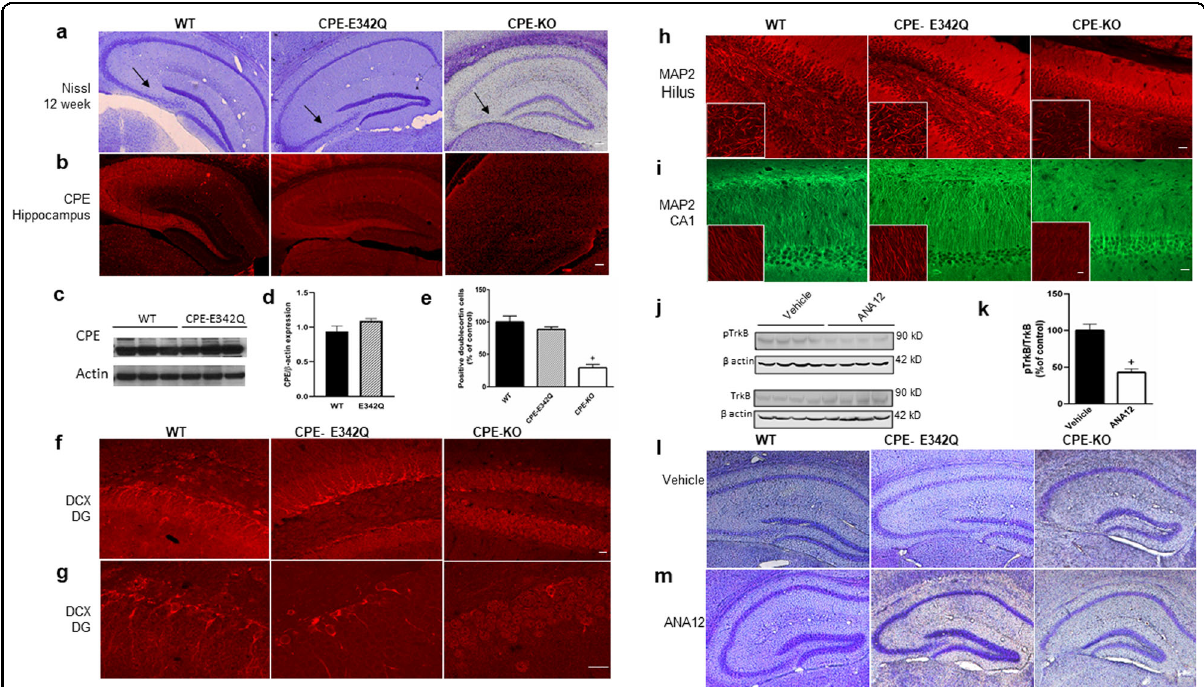
Fig. 3 CPE-E342Q mice show no hippocampal neurodegeneration after weaning stress, unlike CPE-KO mice, and this effect was not blocked by TrkB inhibitor. a Representative sections of Nissl staining of coronal anterior hippocampus of 12-week-old WT, CPE-E342Q, and CPE-KO mice. CPE-E342Q mice showed an intact hippocampus similar to WT mice, however, CPE-KO mice exhibited complete degeneration of the CA3 region (see arrow). Scale bar = 100 μ m. n = 3 mice per genotype. b Immunohistochemistry of representative sections showing intense CPE staining in hippocampal CA1 and CA3 regions in WT and CPE-E342Q mice, but absence in CPE-KO mice. Sale bar = 100 μ m. n = 3 mice per genotype. c , d Western blot and quanti fi cation of expression of CPE in the hippocampus of WT and CPE-E342Q mice. Student ’ s t test, p = 0.149. n = 3 mice per genotype. Values are mean ± SEM. e Bar graphs showing % of DCX positive cells in the dentate gyrus of CPE-E342Q mice compared to WT and CPE- KO mice. Note the decreased number of DCX positive cells in CPE-KO but not CPE-342Q mice. One-way ANOVA analysis followed by Tukey ’ s post hoc multiple comparison test, [ F (2,6) = 43.32, p = 0.0003]. + p = 0.0003 for CPE-KO mice compared with WT which was made = 100%. n = 3 per each genotype. Values are mean ± SEM. f , g Representative confocal images captured at 20X and 60X, respectively, of doublecortin (DCX) immuno fl uorescence staining showing decreased hippocampal dentate gyrus (DG) neurogenesis in CPE-KO mice, but not in WT and CPE-E342Q mice. Scale bars in F = 20 μ m and G = 20 μ m. n = 3 mice per genotype. h MAP2 immuno fl uorescence staining images captured at 20X and 60X (left bottom insert) showing decreased MAP2 intensity in the hilus of CPE-KO mice, but not in WT and CPE-E342Q mice. n = 3 per genotype. Scale bar = 20 μ m. i MAP2 immuno fl uorescence staining images captured at 20X and 60X (left bottom insert) showing decreased MAP2 intensity in the hippocampal CA1 region of CPE-KO mice, but not in WT and CPE-E342Q. n = 3 per genotype, Scale bar = 20 µm. j , k Western blot and bar graph of pTrkB and TrkB levels in the hippocampus of mice treated with ANA12 or vehicle. WT animal received ANA12 or vehicle treatment for 2 weeks and hippocampus was dissected to determine pTrkB/TrkB levels. Using this paradigm, ANA12 effectively decreased pTrkB/TrkB to 43.08% compared with vehicle-treated (control) mice. Student ’ s t test, + p = 0.001 for ANA12 treatment compared with vehicle. Values are mean ± SEM, n = 4 mice/ condition. l , m The effect of TrkB inhibitor, ANA12 on hippocampal CA3 region in CPE-WT, CPE-E342Q, and CPE-KO mice after weaning stress. Representative Nissl staining of sections of coronal anterior hippocampus of WT, E342Q, and CPE-KO mice at week 4 after ANA12 treatment. All mice were toe clipped within postnatal day 7 and received ANA12 i.p injection starting from postnatal day 14 for 14 days. Mice were weaned, tail clipped, and ear tagged at 3 weeks of age and sacri fi ced at week 4. n = 4 mice/condition, scale bar = 100